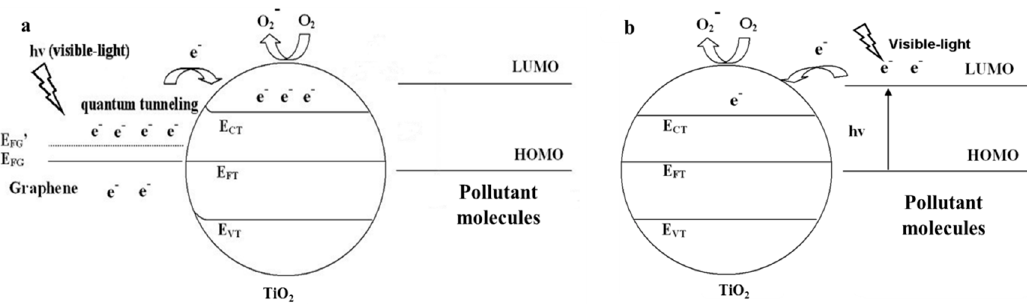
Figure 5. Photocatalytic mechanisms of the ( a ) graphene-TiO 2 composite and ( b ) self-degradation of dye with pure TiO 2 under visible light irradiation. Reproduced with permission from [14]. Copyright Elsevier, 2013.